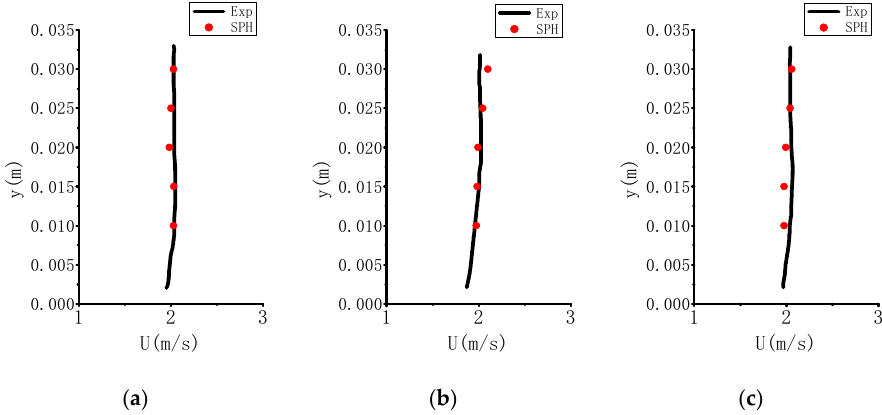
Figure 5. Comparisons between experimental and parallelSPHysics velocity profiles at x = 8.1 m for the critical flow depth h c : ( a ) 0.0635 m; ( b ) 0.0716 m; ( c ) 0.07935 m.